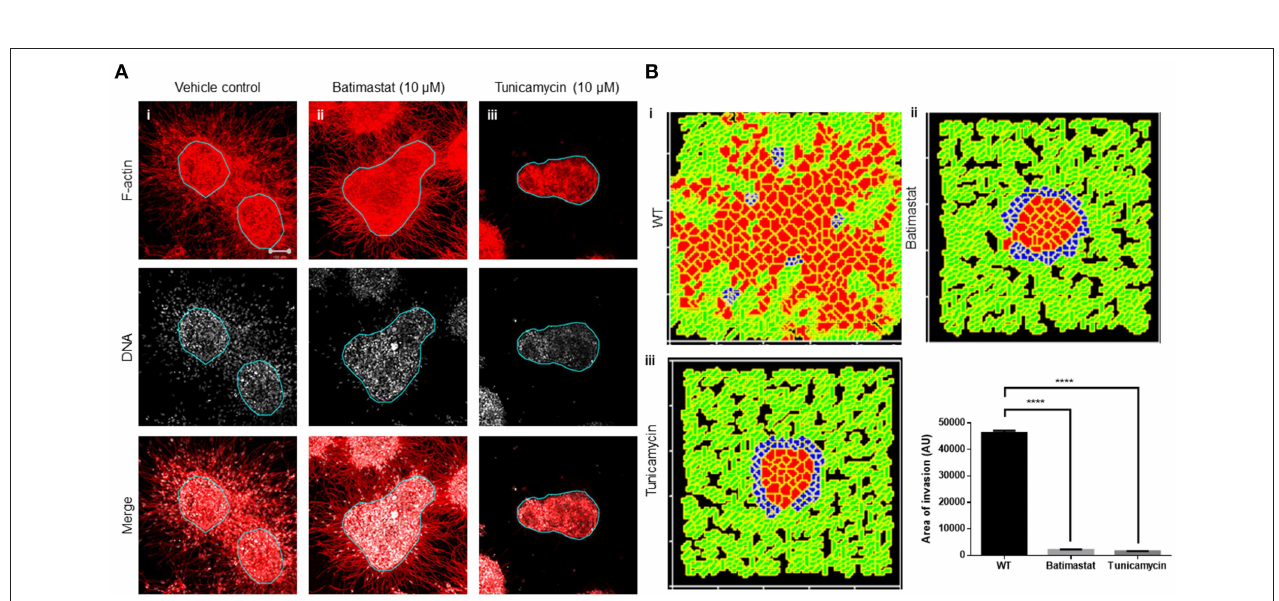
FIGURE 4 | Inhibition of matrix metalloproteinase activity and N-linked glycosylation inhibit multiscale invasion. (A) Maximum intensity projections of laser confocal micrographs of MDA-MB-231 cell clusters cultured within specific matrix milieu, fixed and stained for F-actin (using phalloidin; red; top row), DNA (using DAPI; white; middle row), and with both signals merged (bottom row). (i) rBM-coated clusters embedded in type 1 collagen treated with vehicle control DMSO show multiscale invasion (left column). (ii) Treatment with 10 µ M Batimastat leads to inhibition of transition of cells to type 1 collagen although cytoplasmic projections of cells in the periphery of the cluster are visible in the fibrillar matrix. (iii) Treatment with 10 µ M Tunicamycin results in complete abrogation of multiscale invasion. (B) Simulations of control conditions (i) , parametric variations analogous with inhibition of R-D (ii) , and parametric variations analogous with inhibition of cell–cell, cell–fibrillar ECM, and R-D (iii) at MCS590. Graph represents invasiveness of cells in simulations associated with (Bi–iii) . Each bar represents mean ± SEM. **** p < 0.0001.